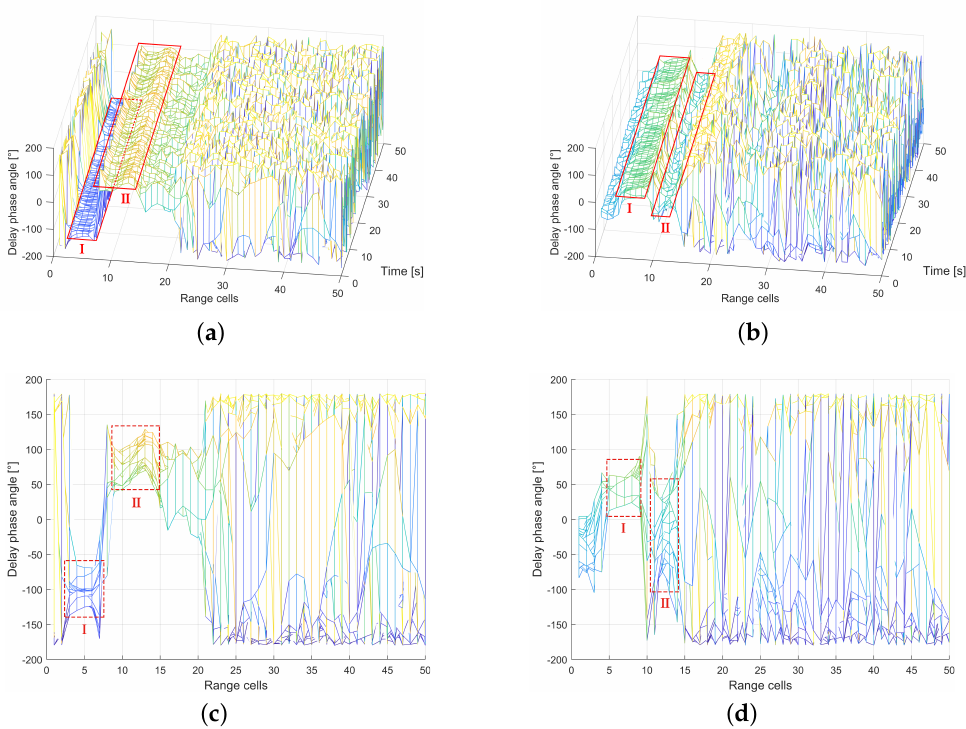
Figure 9. Extracted phase results ( a ) 3D view of C01 observation ( b ) 3D view of C04 observation ( c ) Side-view of C01 observation ( d ) Side-view of C04 observation.